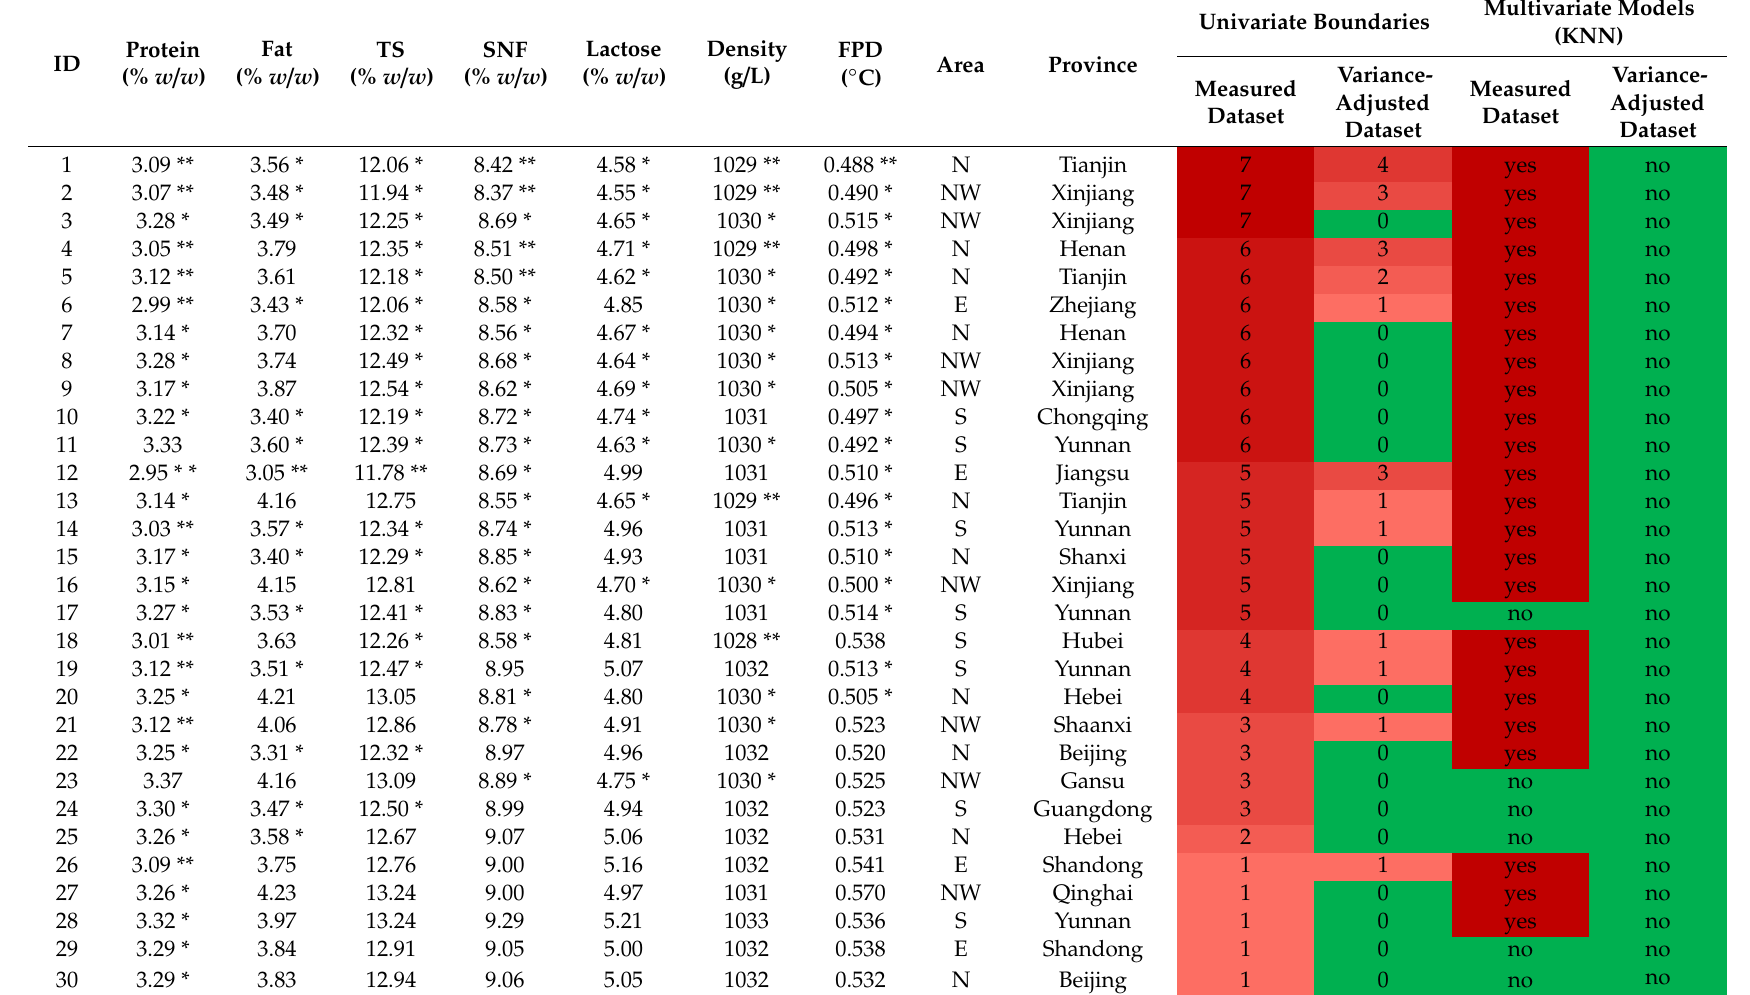
Table 3. The results of the suspected samples in the market survey set according to the developed detections a